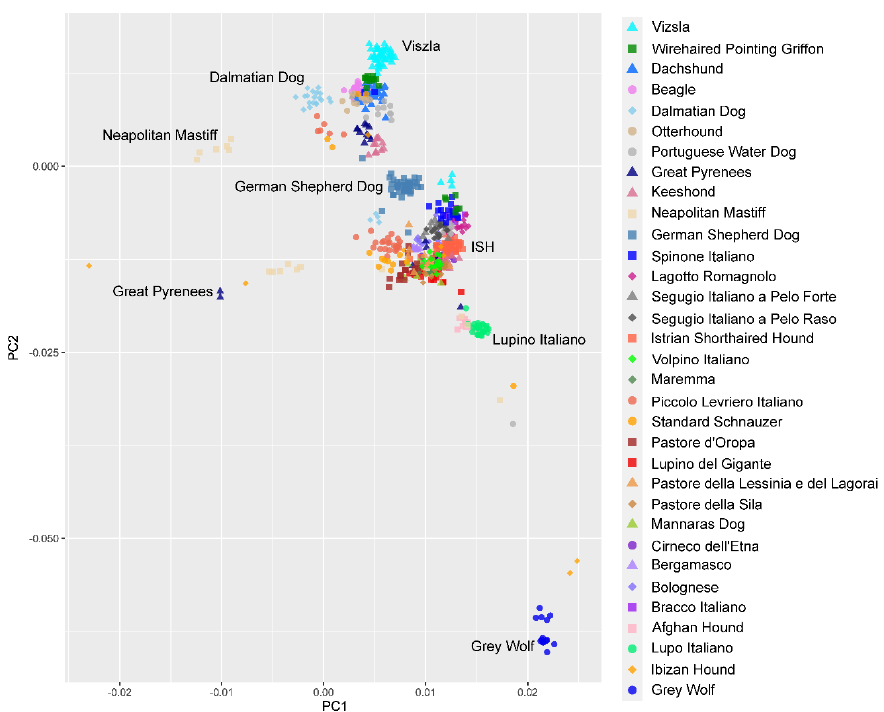
Figure 5. Zoom-in of the Mediterranean breeds cluster (Figure 4), highlighting a subset of 665 dogs which belong to 31 breeds related to the Istrian shorthaired hound (ISH).